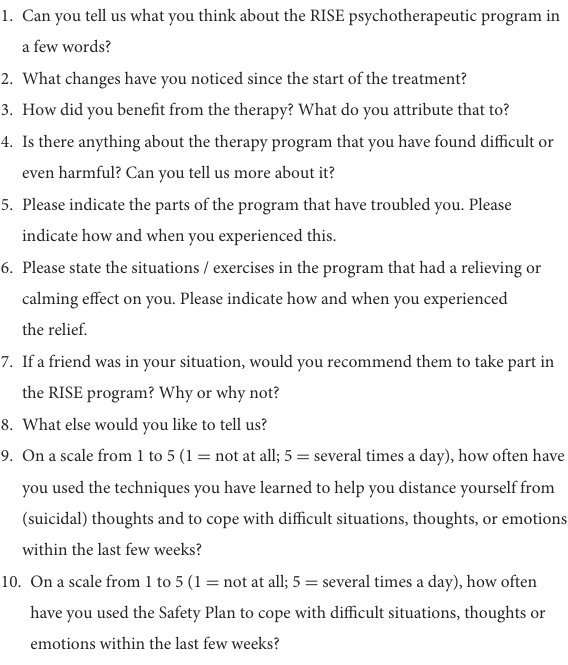
TABLE 2 Questions regarding the RISE